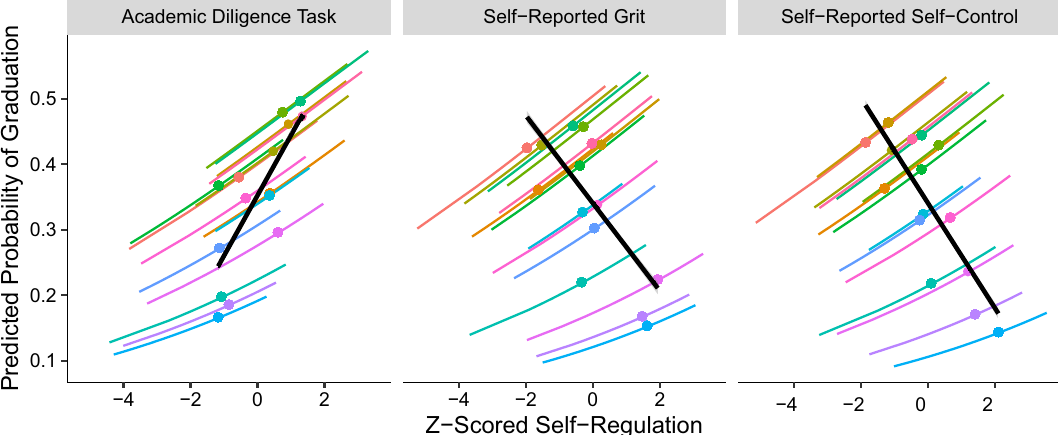
Figure 4. In Study 3, comparing students within schools (colored lines), higher self-regulation predicted higher odds of college graduation, whether measured by self-report questionnaires for grit and self-control or by a behavioral task called the Academic Diligence Task. When comparing schools to each other, however, higher self-reported grit and self-control scores predicted lower graduation rates, whereas the behavioral task positively predicted college graduation, as shown in the solid black lines. Plots show predicted probabilities of graduation from multilevel logistic regression models. AUC s for models predicting the academic diligence task, self- reported grit, and self-reported self-control were 0.694, 0.693, and, 0.676,